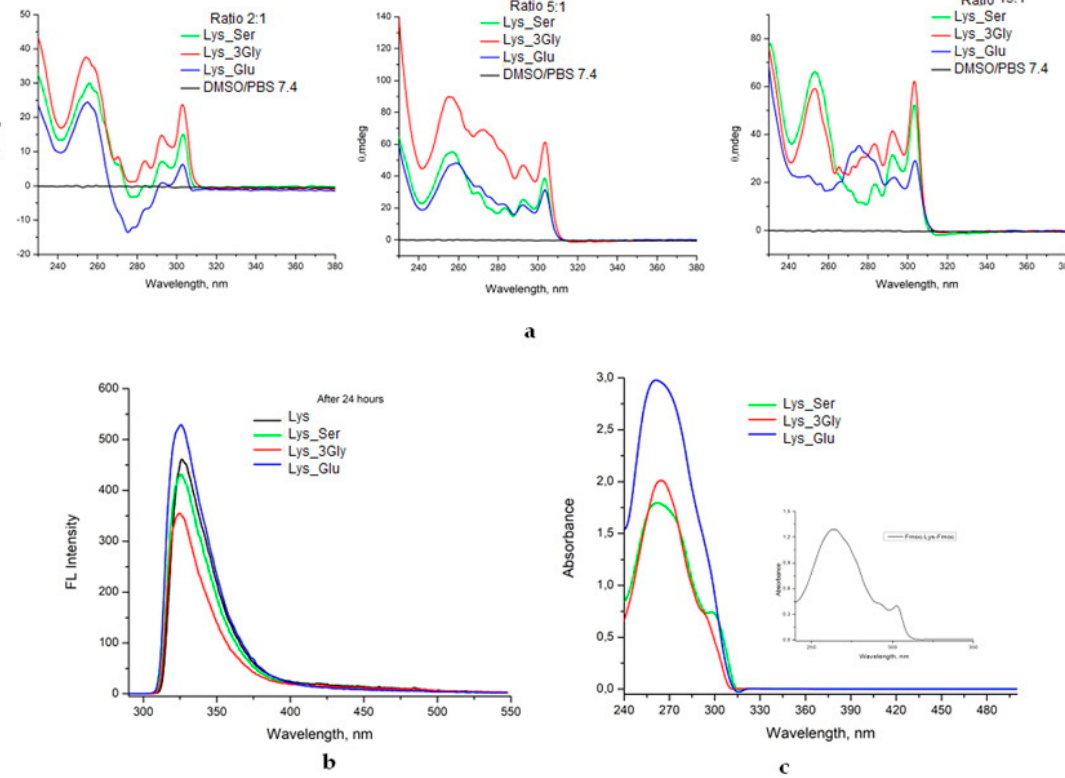
Figure 4. ( a ) CD spectra, ( b ) fluorescence spectra and ( c ) UV-VIS spectra for the co-assembled structures in solution.